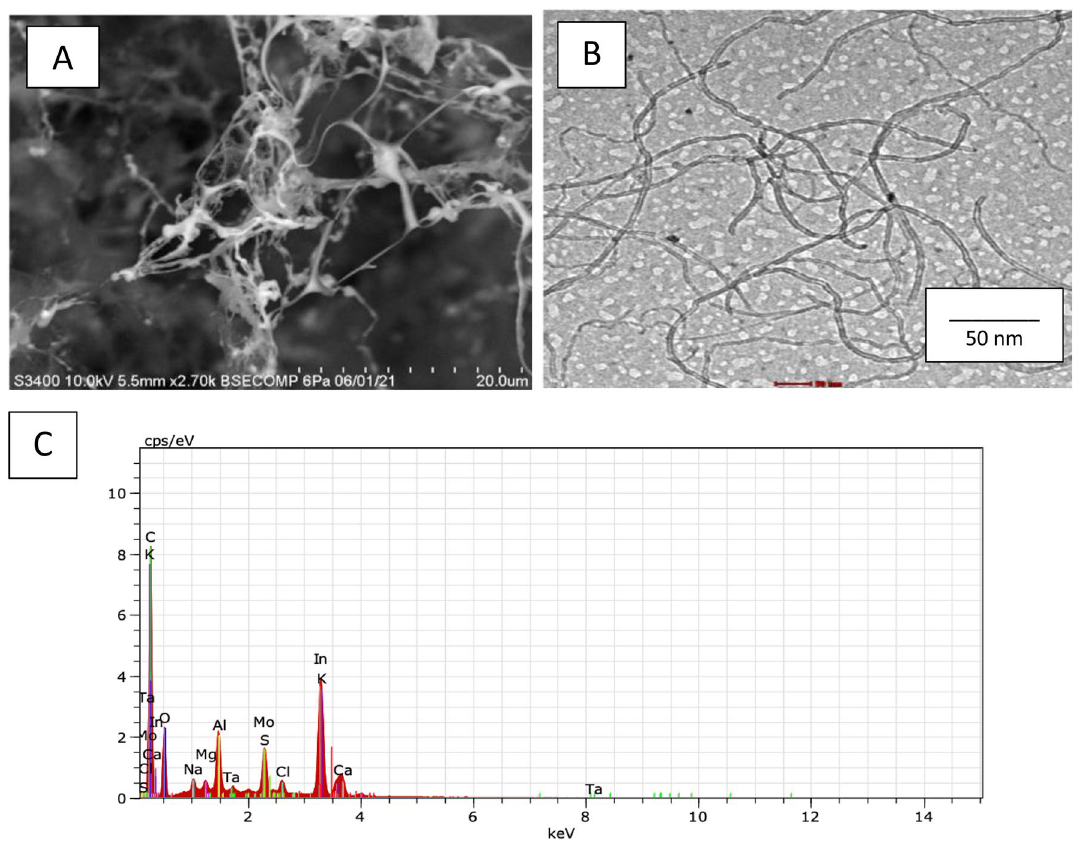
Figure 2. f-MWCNTs were observed under different magnifications: ( A ) SEM under magnification of 20 um, ( B ) TEM under magnification of 50 nm and ( C ) EDX analysis.